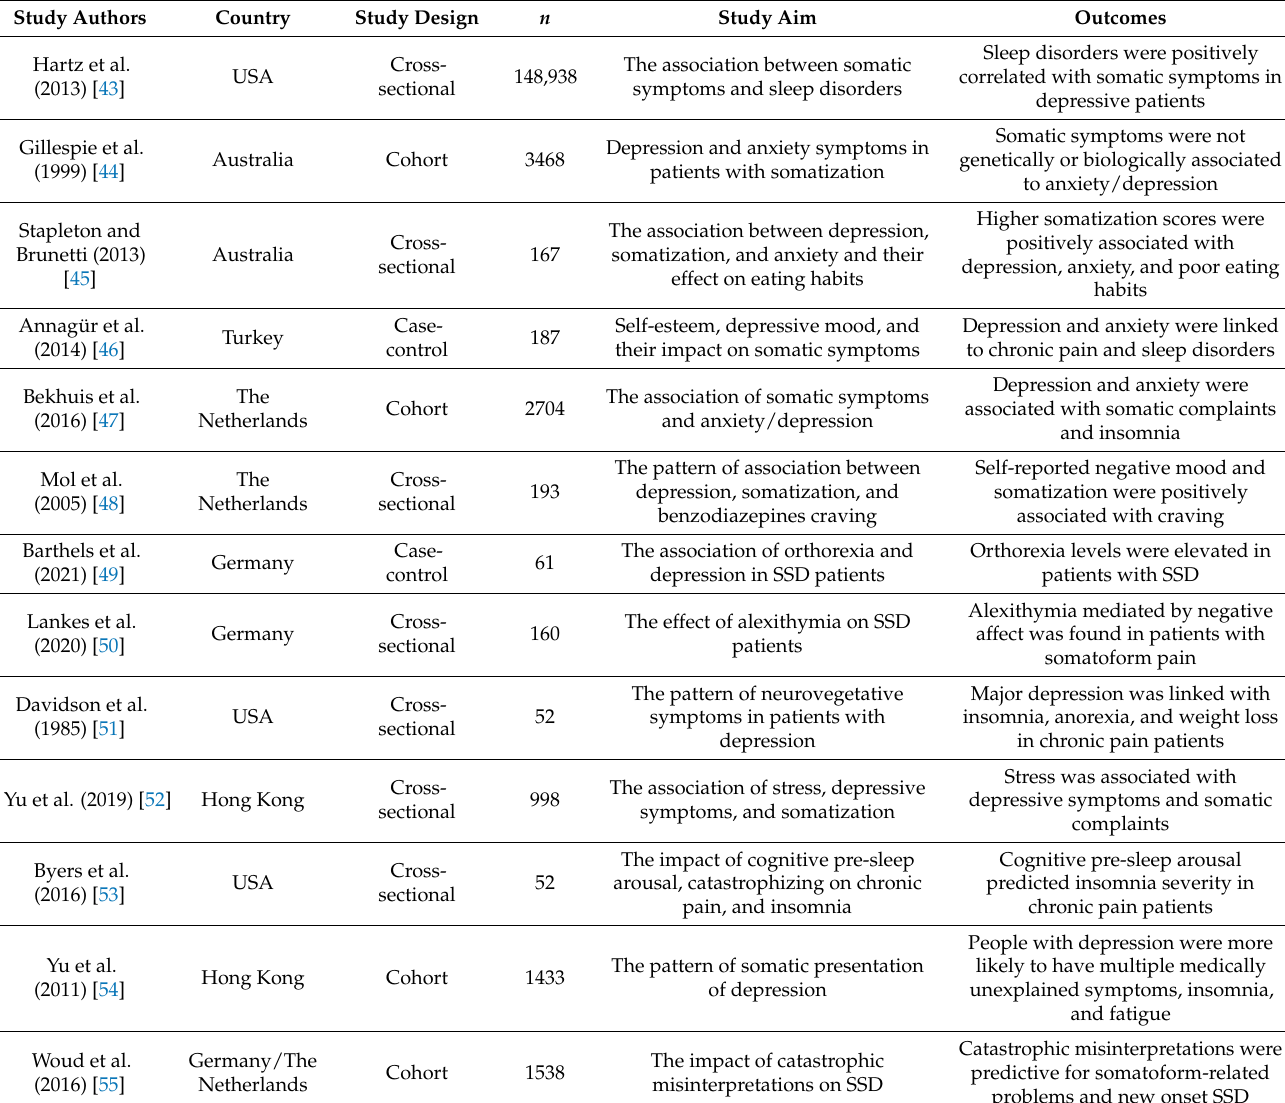
Table 2. Comorbidities in patients with SSD and sleep disorders.